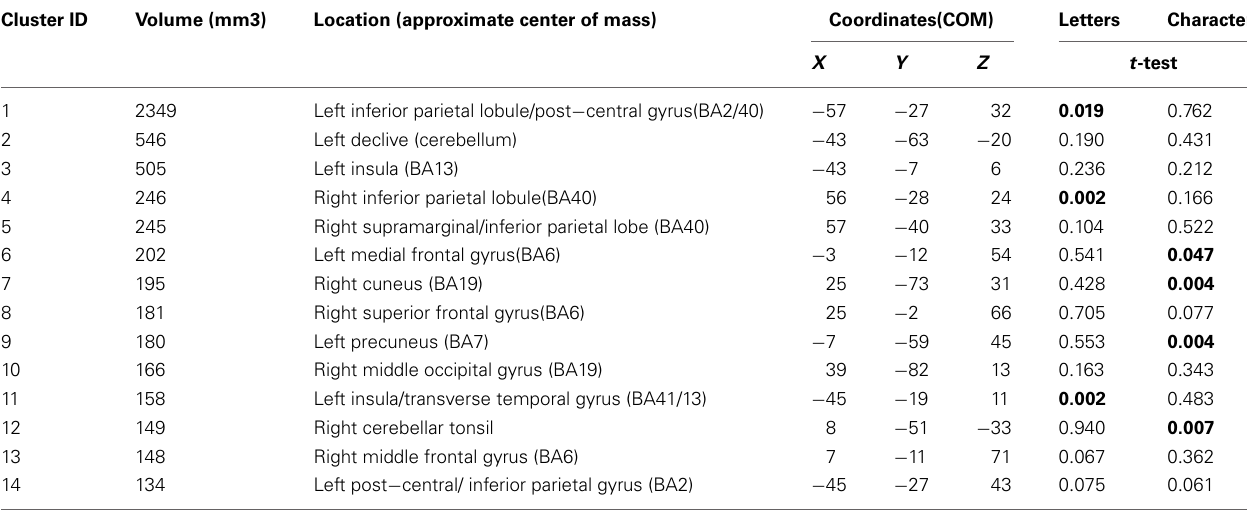
Table 5 | Voxelwise ANOVA—Group × Condition Interaction (letters/characters). Cluster